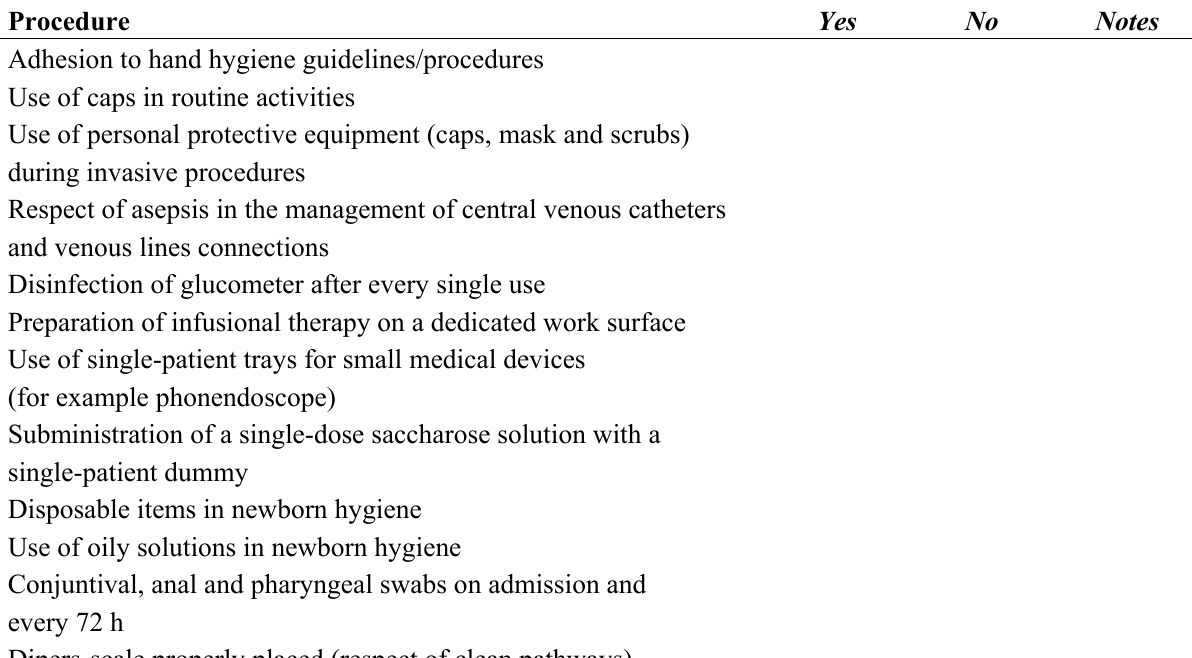
Table 1. Check-list for the evaluation of the NICU staff compliance to the infection control measures.